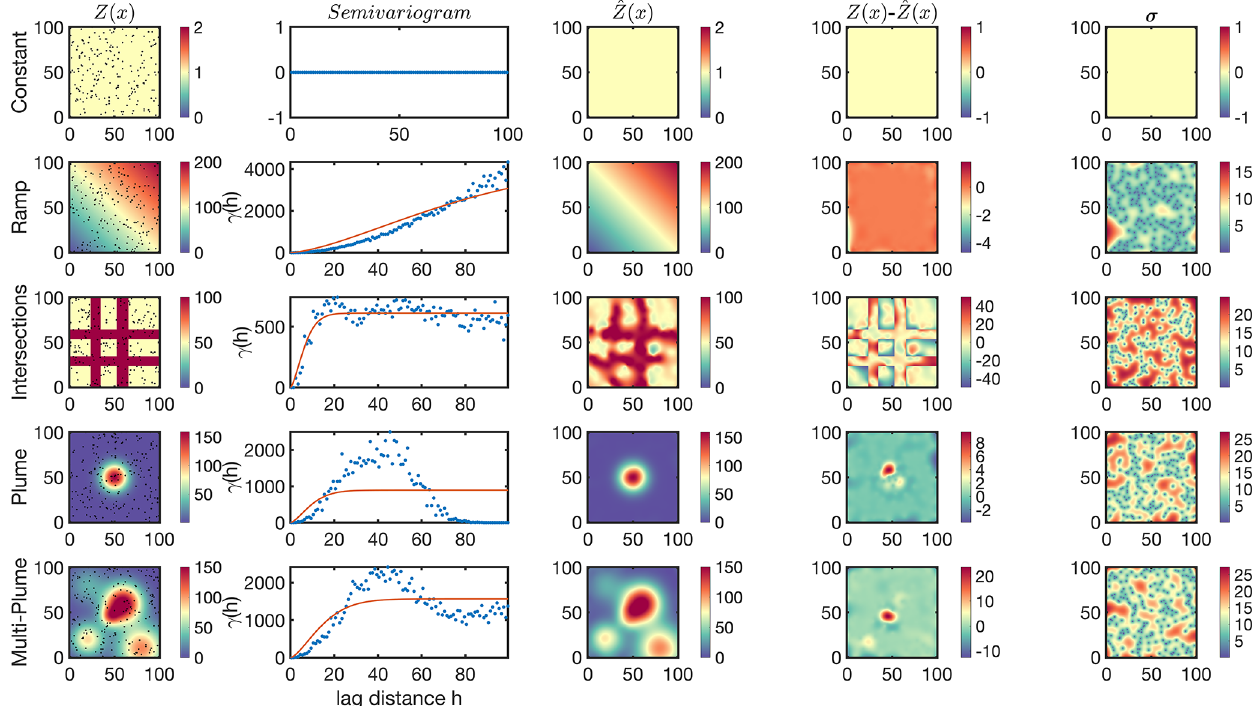
Figure 1. First column: five theoretical fields randomly sampled with 200 points (dots), namely, a constant field (C1), a ramp starting from zero in the lower left to higher values in the upper right (C2), an intersection with concentrated values in four corridors (C3), a Gaussian plume placed in the center (C4), and multiple Gaussian plumes spread over the entire domain (C5). Second column: the corresponding isotropic semivariograms computed based on Eq. (2); the red line shows the stable Gaussian fitted to the semivariogram based on the Levenberg– Marquardt method. Third column: the kriging estimate at the same resolution of the truth (i.e., 1 × 1) based on Eq. (6). Fourth column: the difference between the estimate and the truth. Fifth column: the kriging standard error based on Eq.